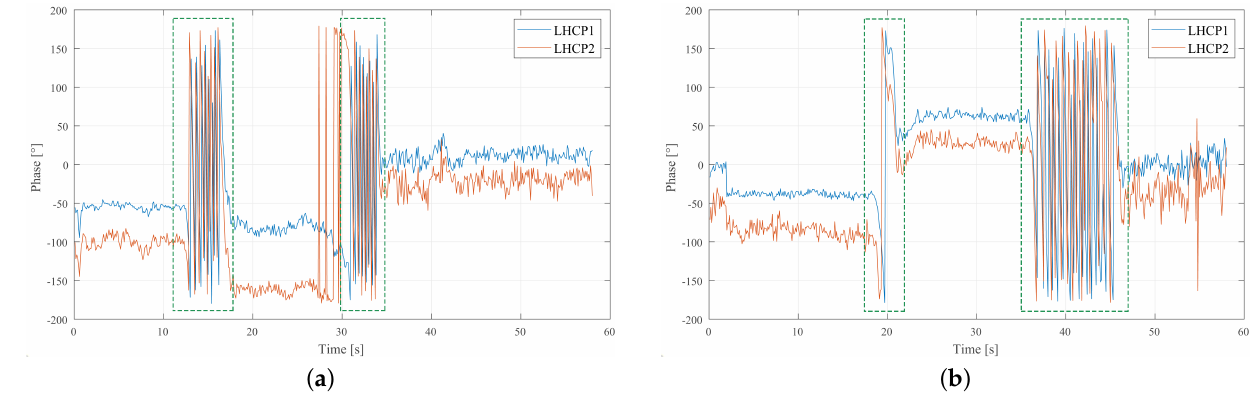
Figure 16. Extracted phase results ( a ) for dataset 1 ( b ) for dataset 2.